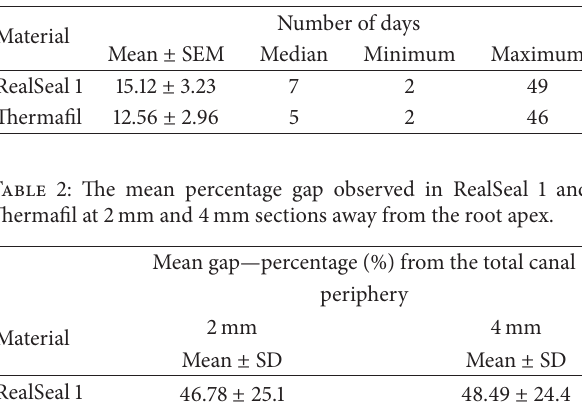
Figure 1: Cumulative survival rates of samples obturated with RealSeal 1 and Thermafil.